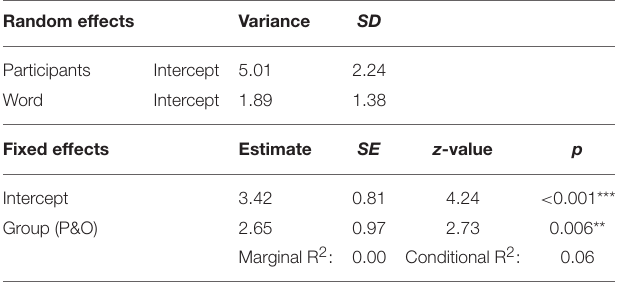
TABLE 4 | Results of mixed-model analysis of the effects of group (Phonology, Phonology & Orthography) on number of pseudowords correctly